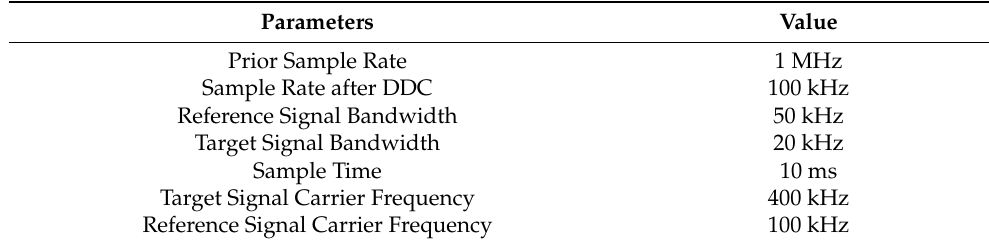
Table 1. Simulation parameters.